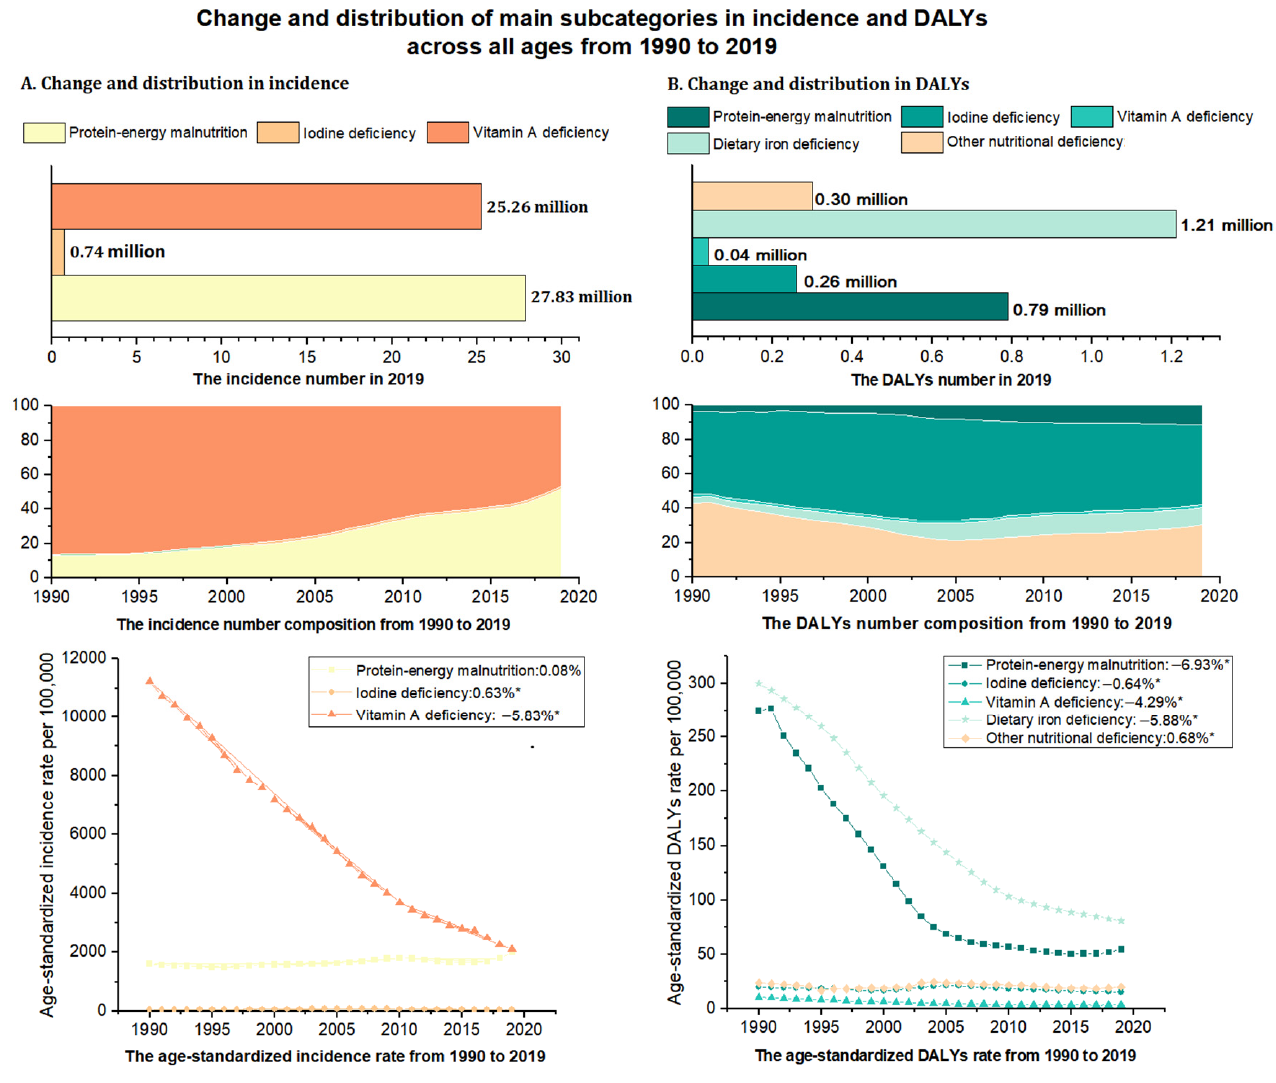
Figure 3. Change and distribution of main subcategories in incidence and DALYs rate in all population from 1990 to 2019 in China. ( A ) Incidence; ( B ) DALYs. DALYs = disability-adjusted life-years. Note: (*) Indicates statistically significant trend ( p < 0.05).